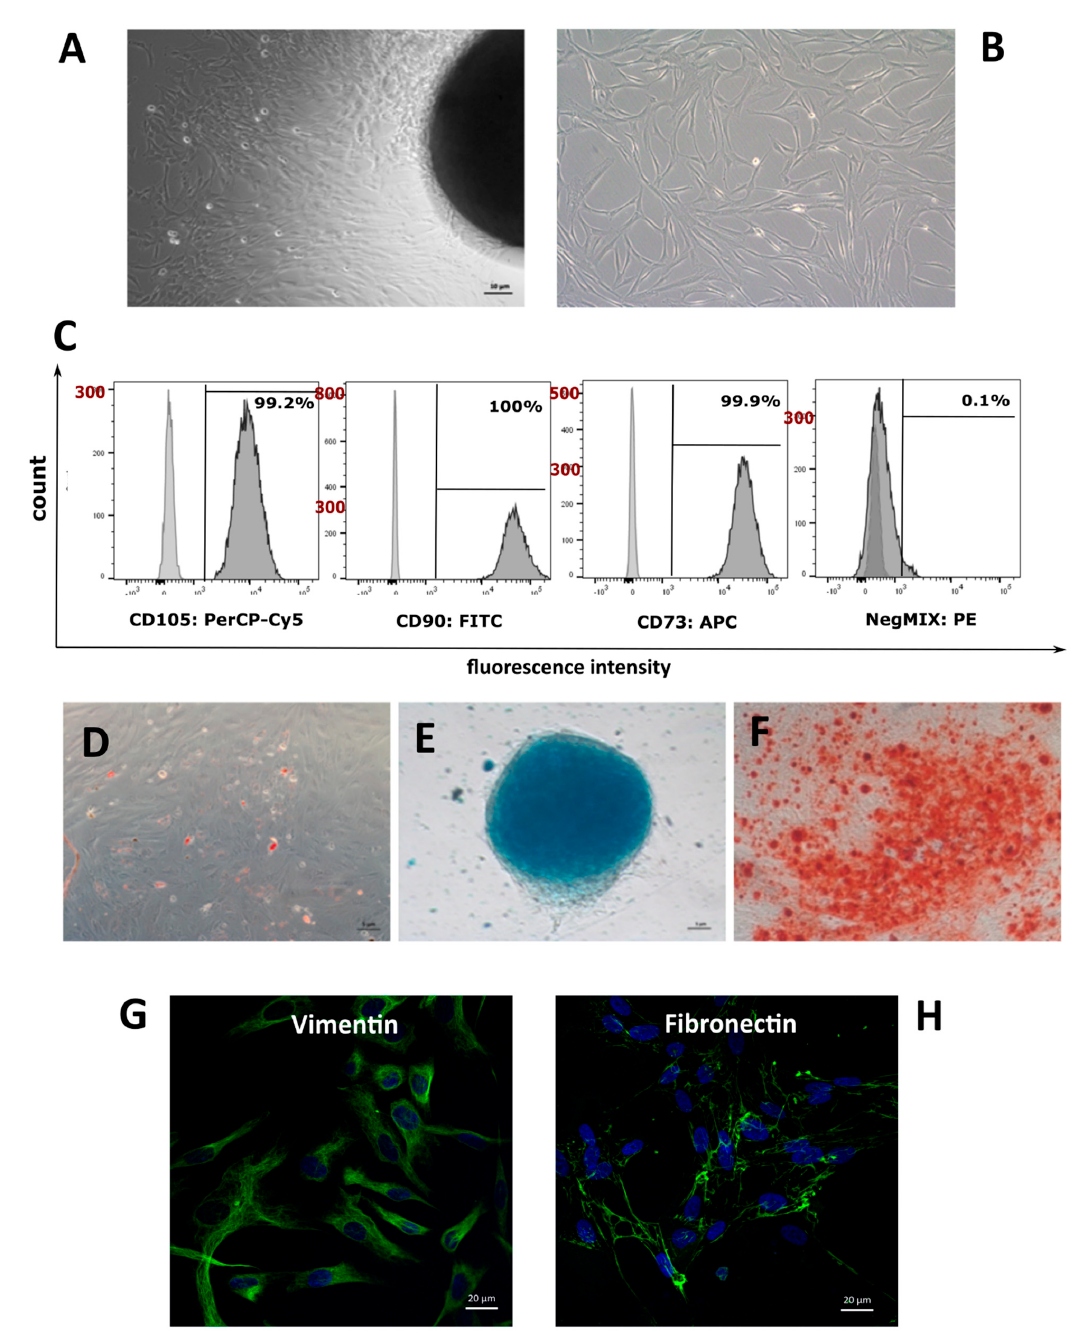
Figure 3. Characterization of non-treated WJ-MSCs. ( A )—WJ-MSCs migration out of the explant derived from Wharton’s jelly. ( B )—a fibroblast-like, adherent WJ-MSCs culture, with elongated, cylindrical shape morphology. ( C )—Flow cytometry analysis. The number of cells expressing CD determines the peak in the lower right quadrant. The latter analysis showed culture with a relatively clear expression of specific mesenchymal markers (CD73, CD90, and CD105)—more than 98% positive markers. Not more than 1% of the WJ-MSCs expressed negative markers (CD34, CD11b, CD19, CD45, and HLA-DR). ( D )—adipogenesis—positive Oil Red staining (red fat drops), ( E )—chondrogenesis: positive Alcian blue staining for the presence of cartilage glycosaminoglycans, ( F )—osteogenesis: positive Alizarin Red staining ( G , H ): immunocytochemical analysis of WJ-MSCs. Cells exhibited of typical cytoskeleton markers expression Vimentin (green- G ) and Fibronectin (green- H